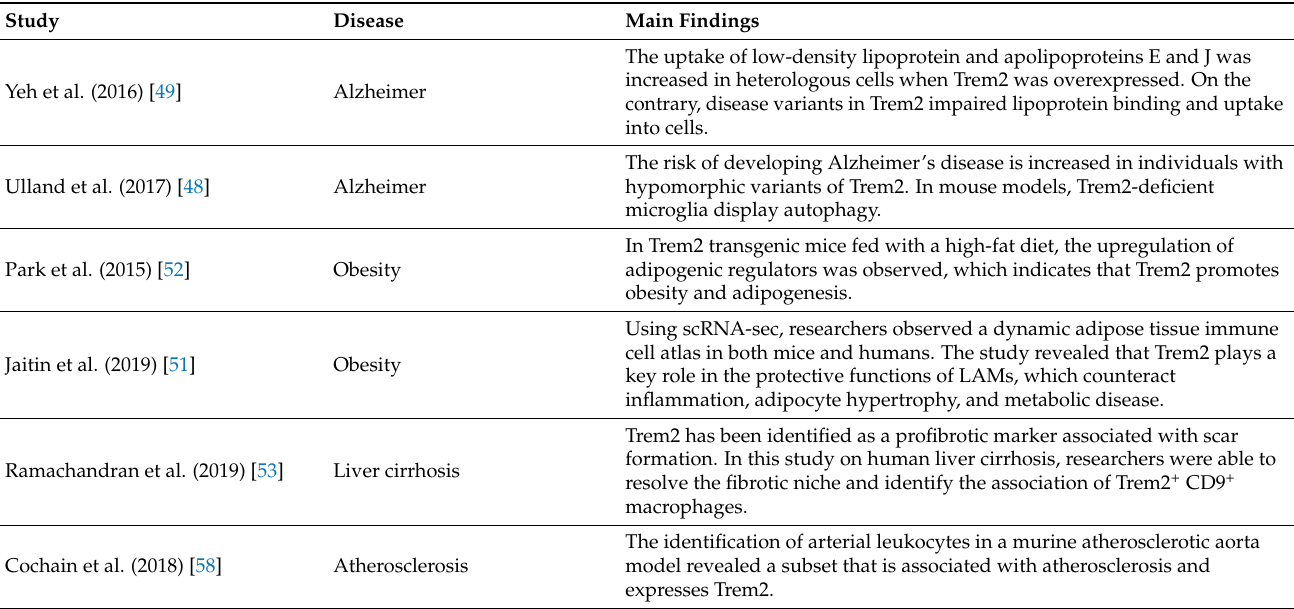
Table 2. Summary of previous studies on the role of triggering receptor expressed on myeloid cells 2 (TREM2) in specific diseases, including cardiovascular